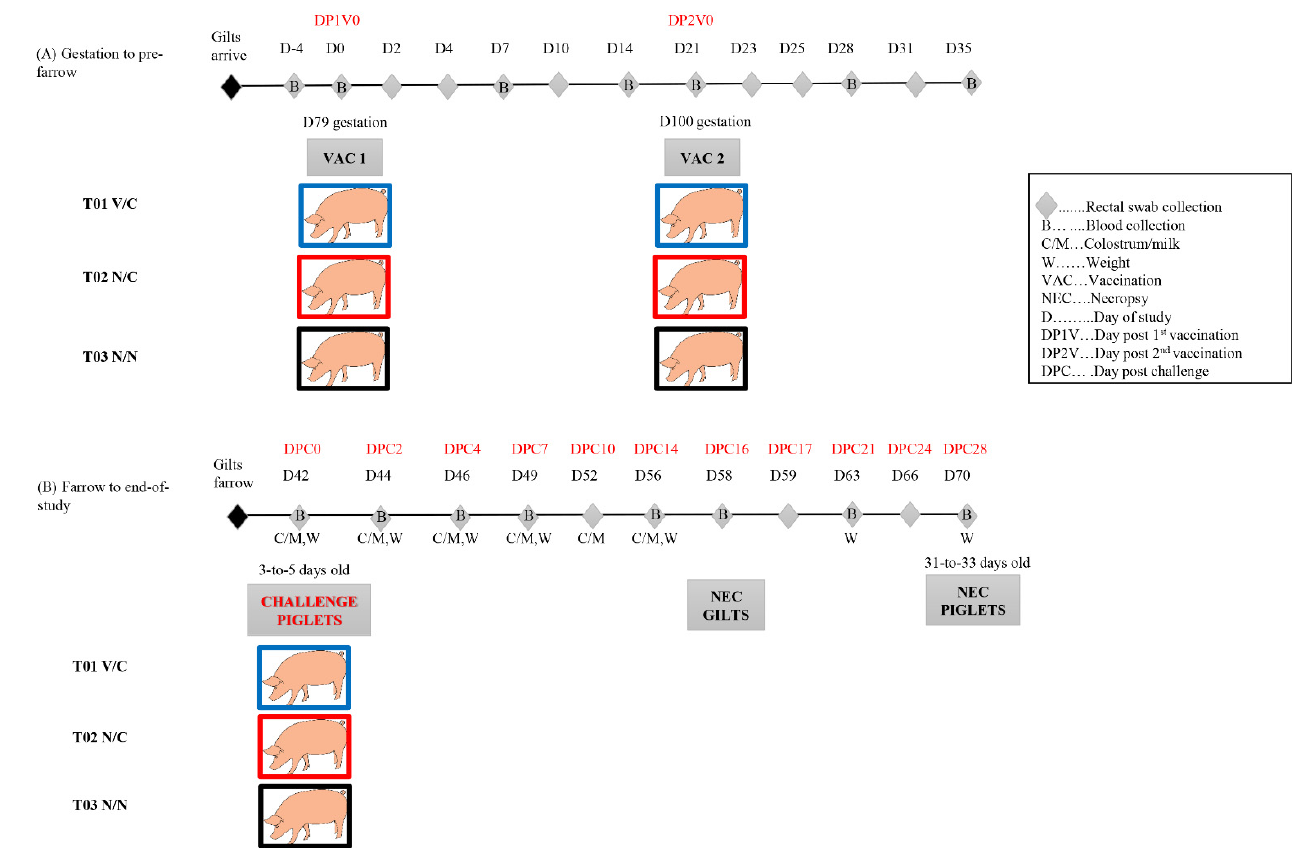
Figure 1. Timeline of sample collection during the major study events. The blue, red and black squares are used to distinguish the gilts in T01 V/C, T02 N/C, and T03 N/N groups.